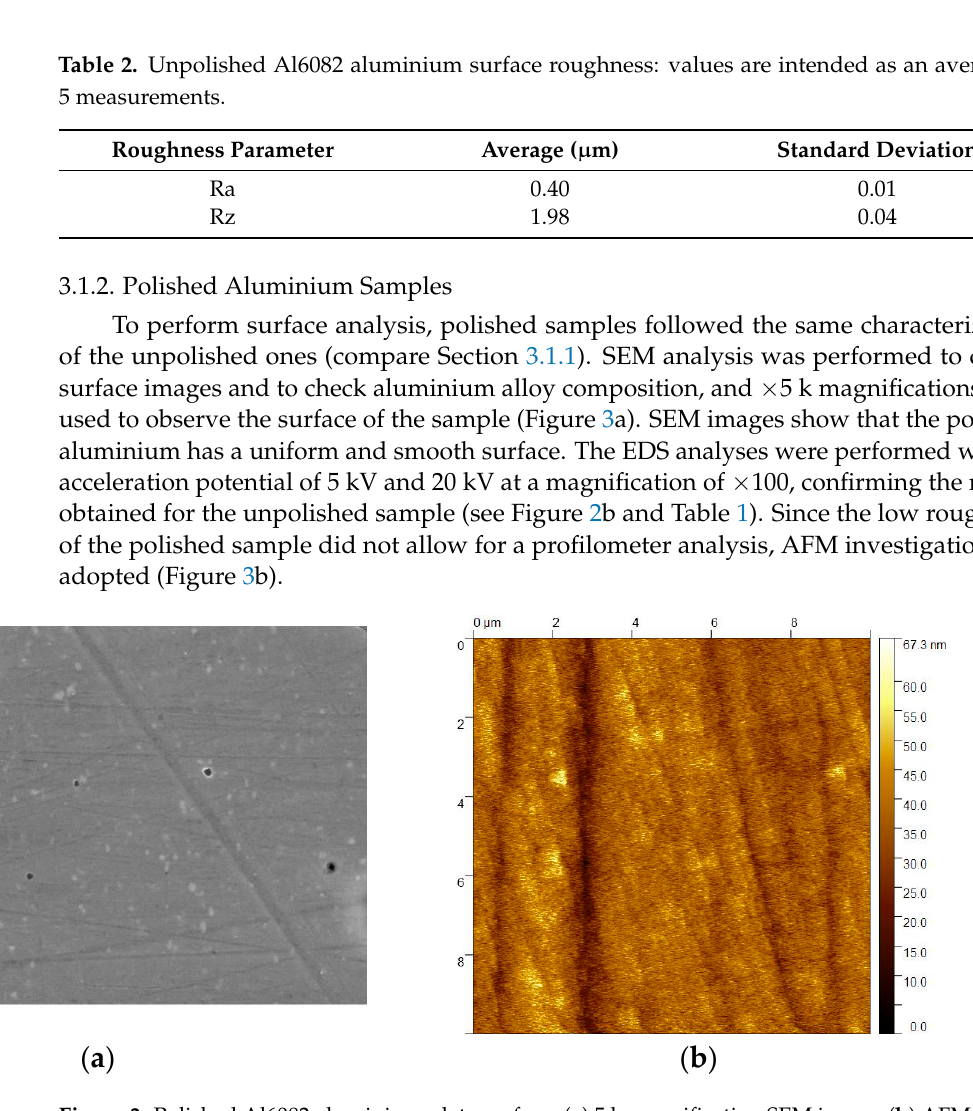
Figure 3. Polished Al6082 aluminium plate surface: ( a ) 5 k magnification SEM image; ( b ) AFM image.